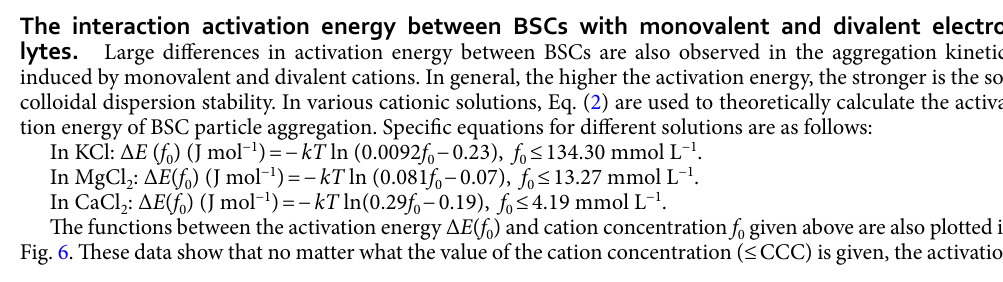
Fig. 6. These data show that no matter what the value of the cation concentration (≤ CCC) is given, the activation